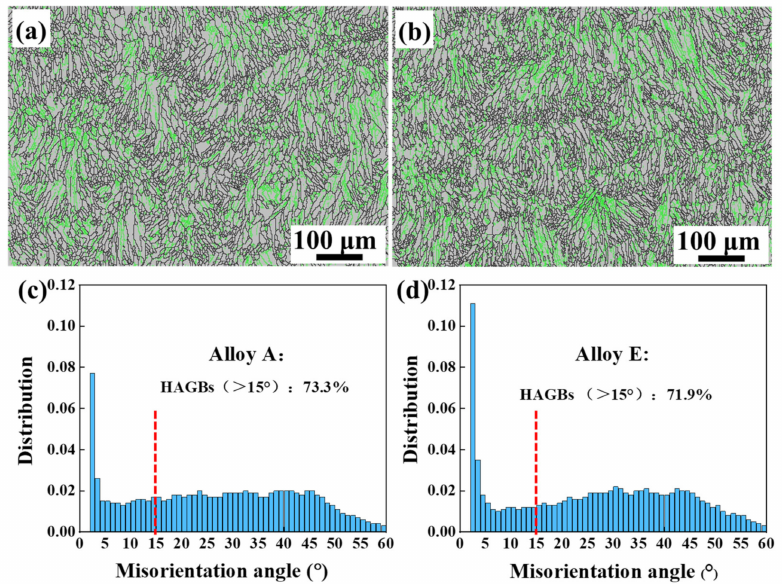
Figure 3. EBSD grain boundary misorientation maps and statistical analysis: ( a , c ) Alloy A, ( b , d ) Alloy